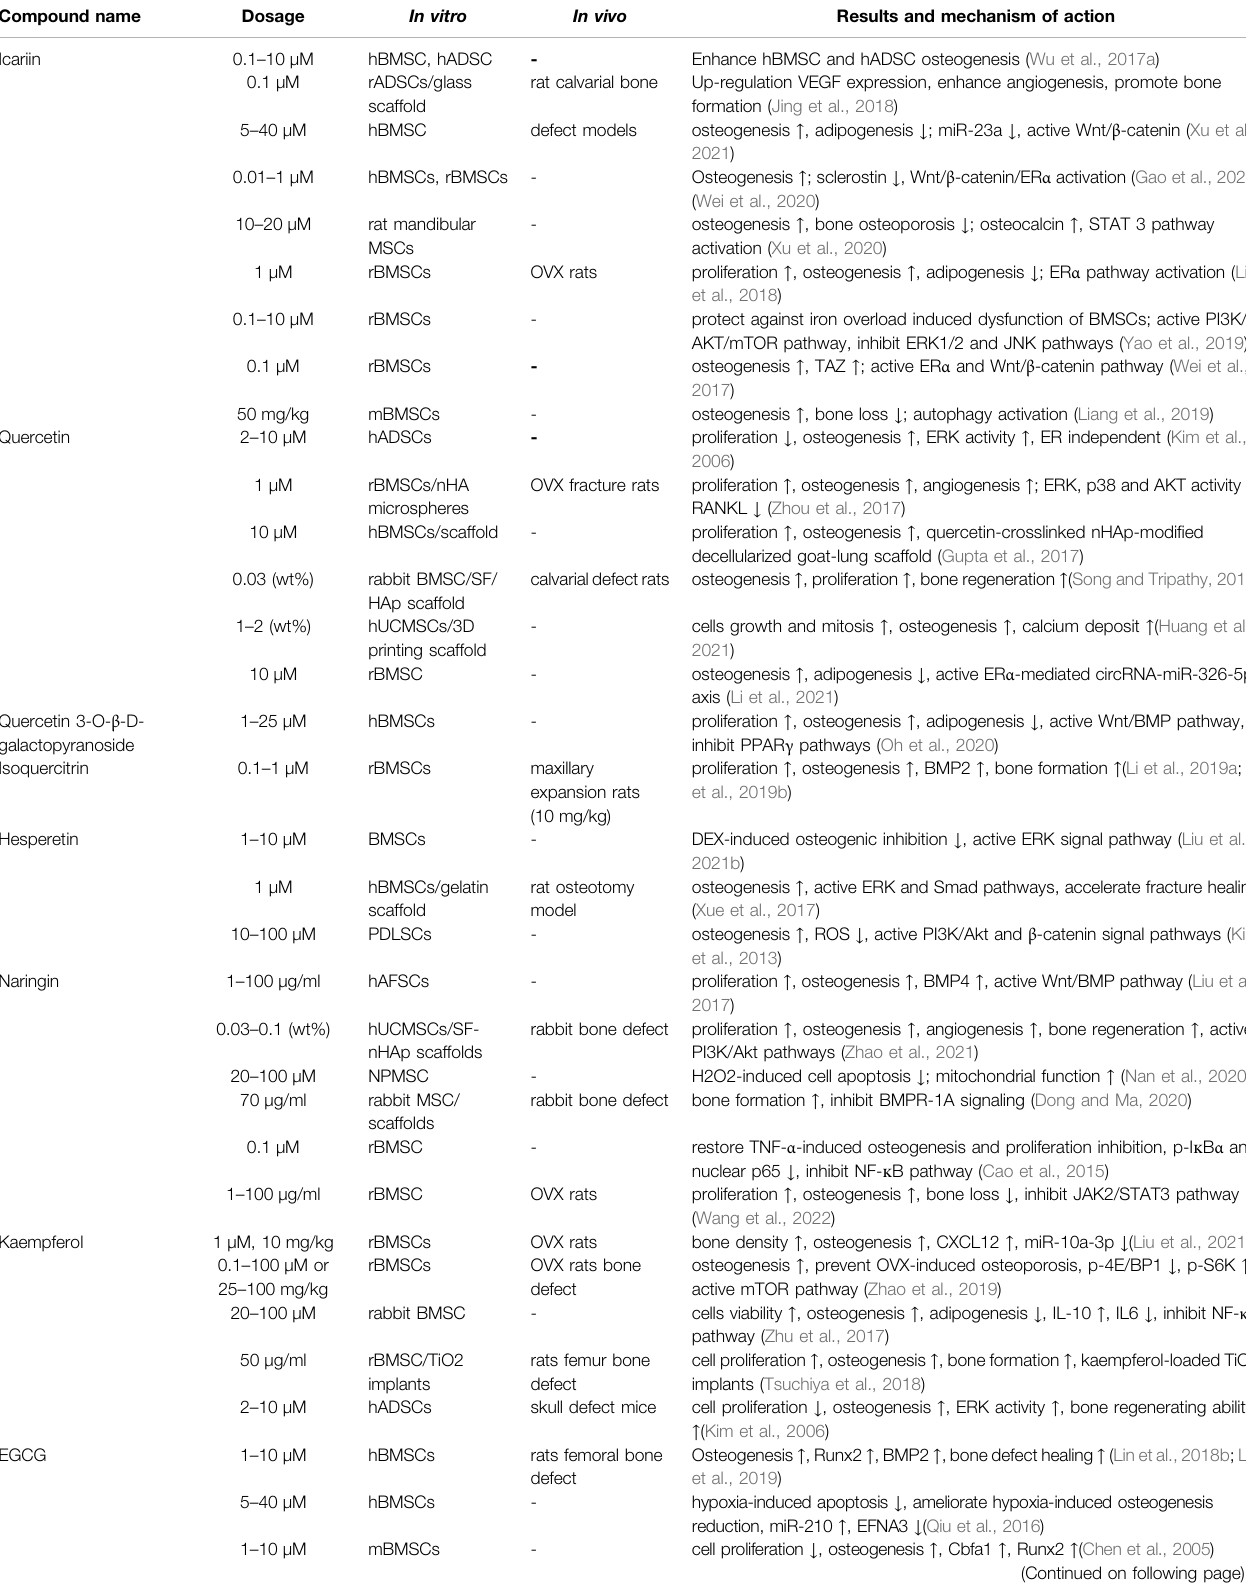
TABLE 2 | The list of some fl avonoids compounds on MSCs osteogenic differentiation. Compound